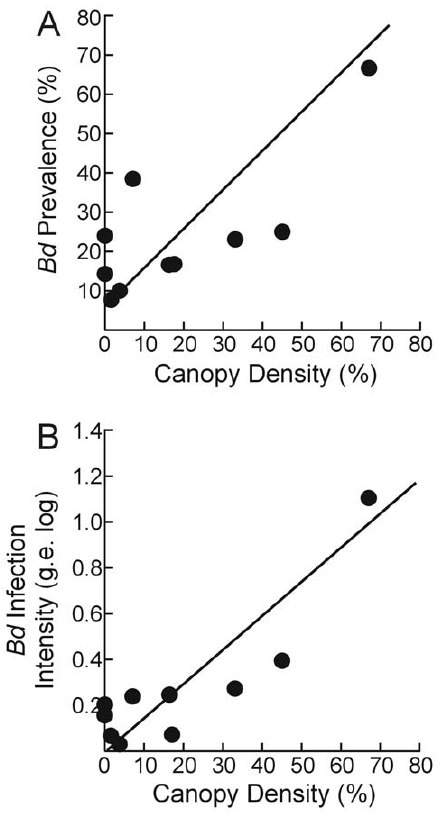
Figure 1. Effect of canopy density on Bd across populations of L.clamitans from the Adirondack region, New York, USA. (A) Bd prevalence; (B) Bd infection intensity.